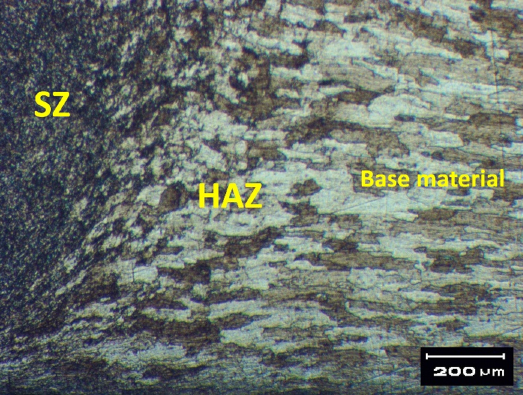
Figure 5. Formation of different areas in Al